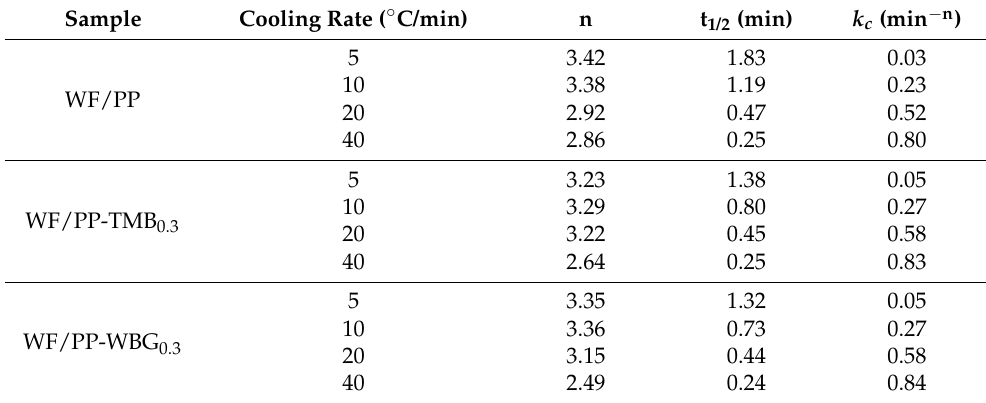
Table 1. Non-isothermal crystallization kinetic parameters for WF/PP, WF/PP-TMB 0.3 and WF/PP-WBG 0.3 .